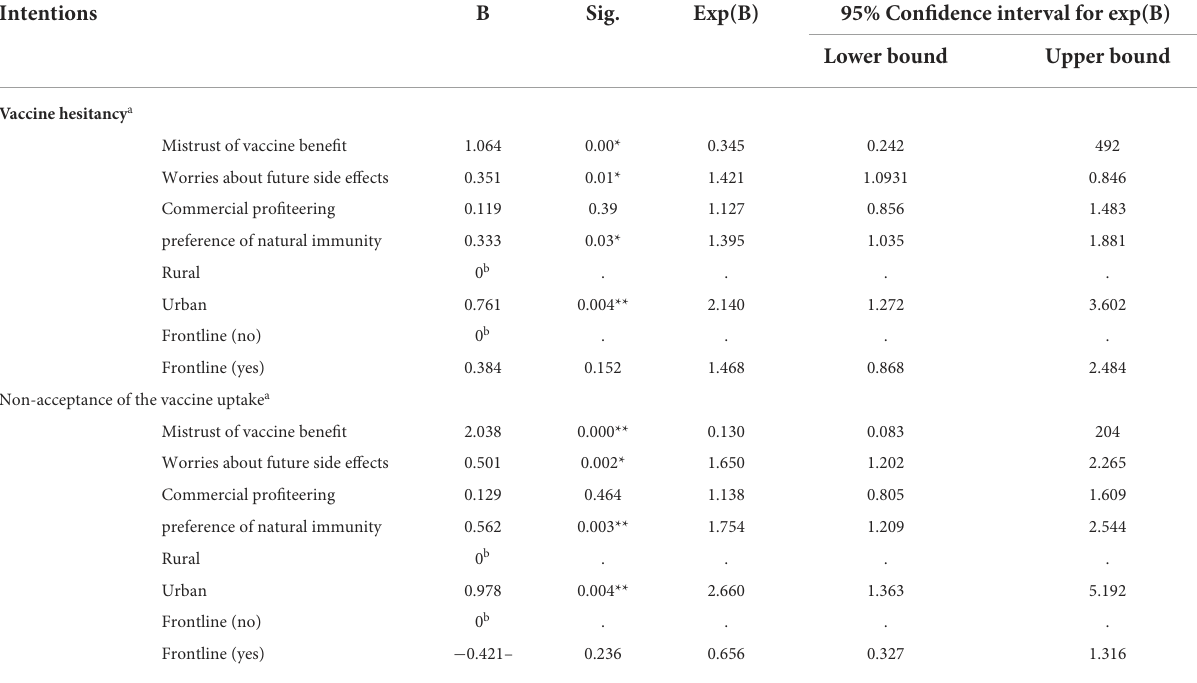
TABLE 7 Multinomial regression analysis for the predictors of the COVID-19 vaccine uptake, hesitancy and non-acceptance. Intentions B Sig. Exp(B) 95% Confidence interval for exp(B) Lower bound Upper